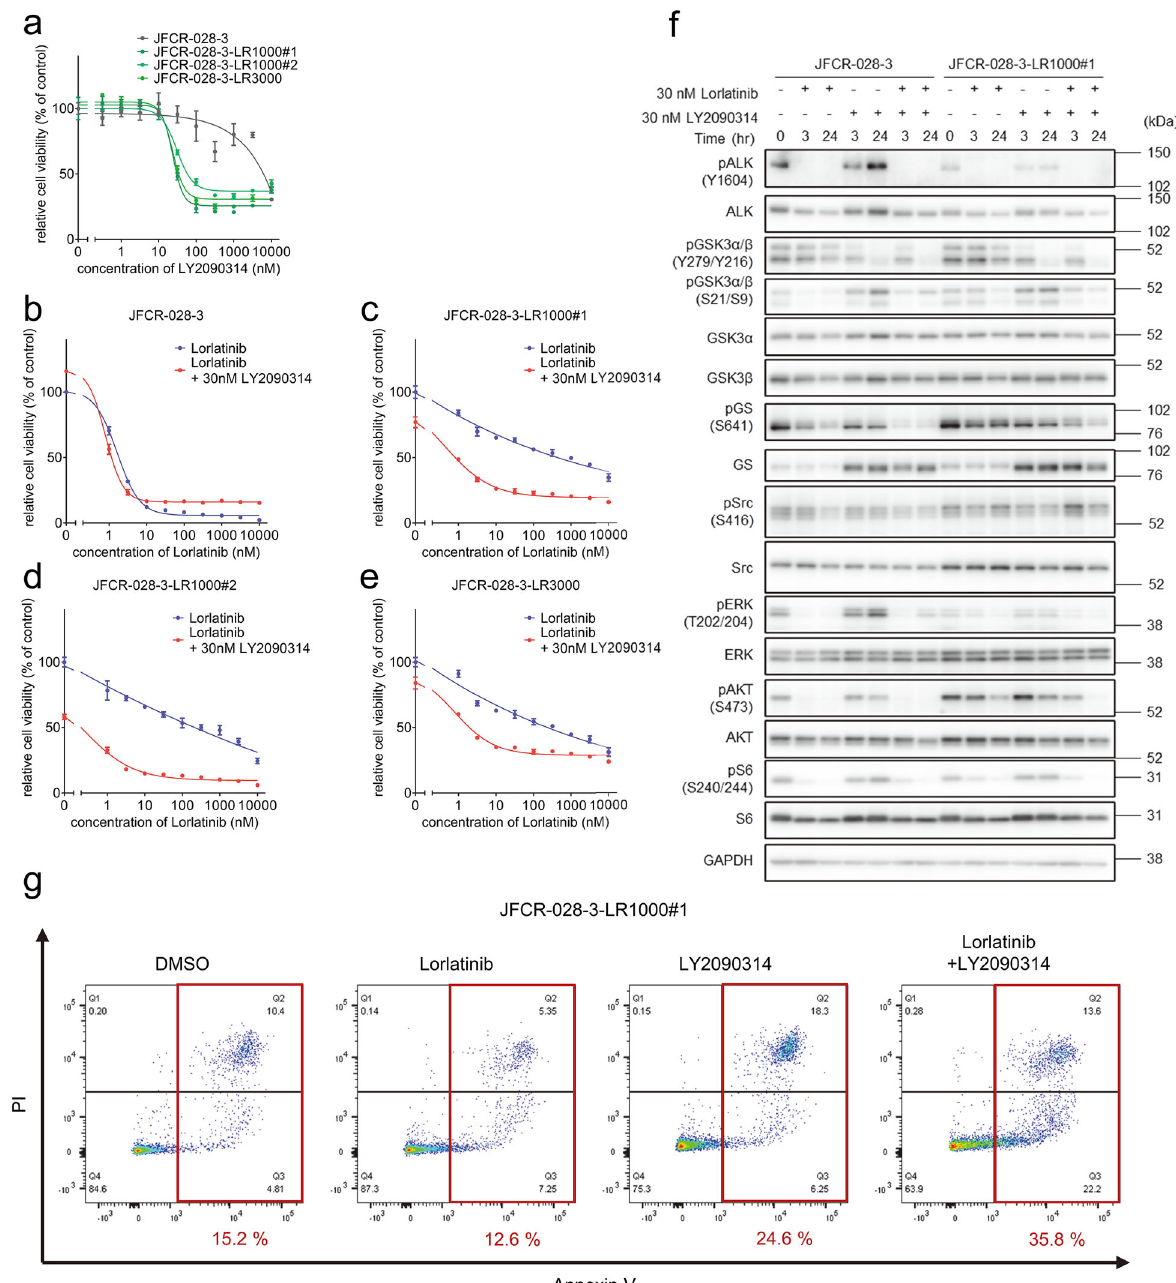
Fig. 3 GSK3 inhibitors resensitized lorlatinib intermediate resistant cells to lorlatinib. a Cell viability of JFCR-028-3 parental and lorlatinib intermediate resistant cells treated with the indicated concentration of LY2090314 for 72 h ( n = 3). Each point represents the mean ± SD of three replicates. Cell viability of b JFCR-028-3 parental and c – e lorlatinib intermediate resistant cells treated with the indicated concentration of lorlatinib in the presence or absence of a fi xed concentration of LY2090314 for 72 h ( n = 3). Each point represents the mean ± SD of three replicates. f Immunoblot analysis of indicated proteins after treatment of JFCR-028-3 parental and JFCR-028-3-LR1000#1 cells with indicated concentrations of lorlatinib in the absence or presence of LY2090314 for 0, 3, and 24 h. GAPDH was used as a loading control. g Apoptosis assay of JFCR-028-3-LR1000#1 cells treated with the 30 nM lorlatinib and 100 nM LY2090314. Apoptosis was evaluated using Annexin-V and PI staining after 72 h of the indicated drug treatment. The apoptotic cells were shown in red square and the percentage of apoptotic cells is shown in red